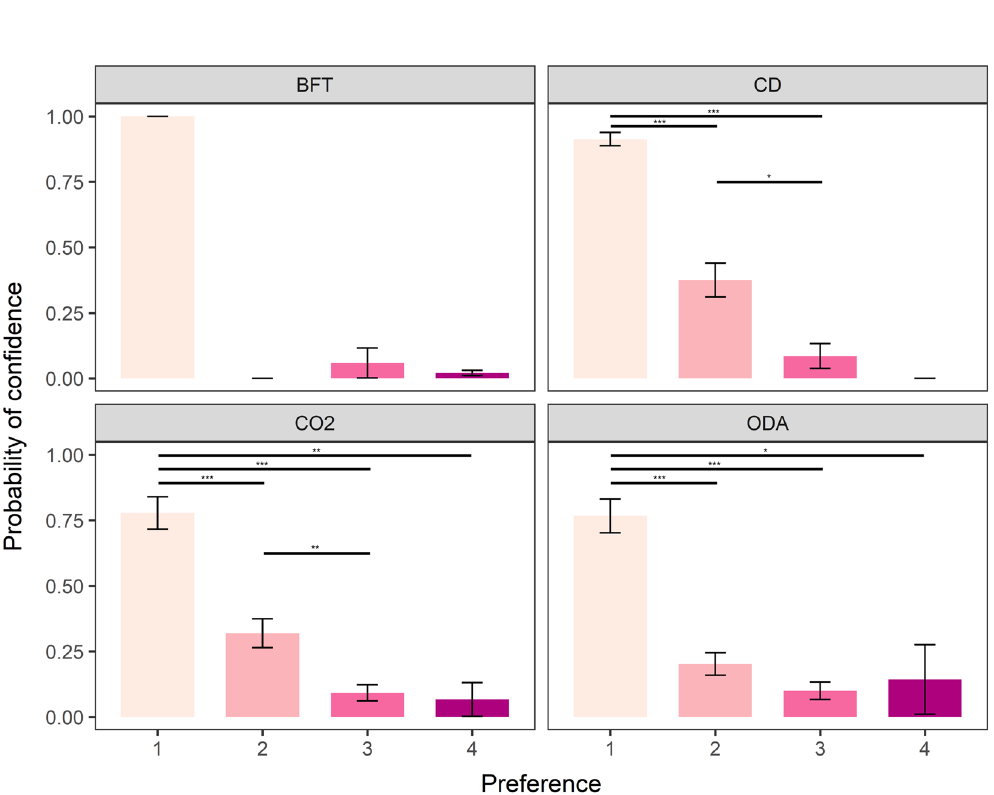
Figure 5. Mean (± SE) probability of participants reporting confidence according to preference ranking order (between 1 and 4 with 1 being most preferred and 4 being least preferred) for each Schedule 1 method. BFT = blunt force trauma, CD = Cervical dislocation, CO 2 = exposure to carbon dioxide, ODA = overdose of anaesthetic. * p < 0.05, ** p < 0.01, *** p <